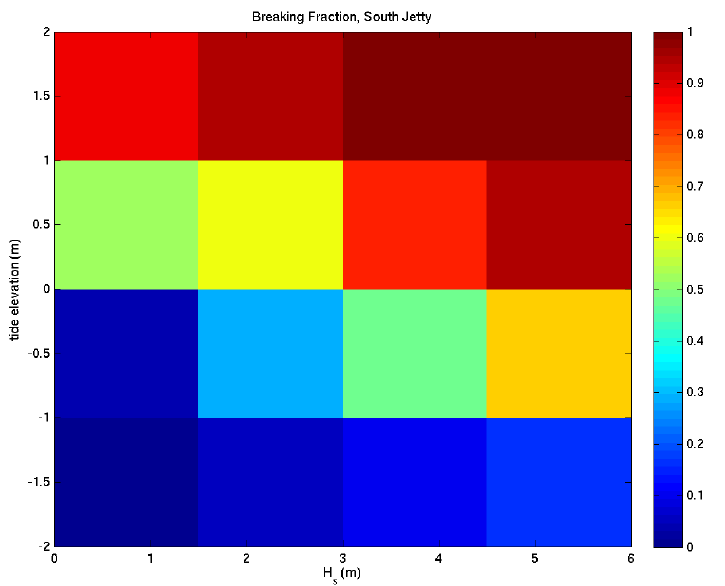
Figure 21. Breaking fraction statistics for the south jetty as a function of wave height and tide eleva- tion.